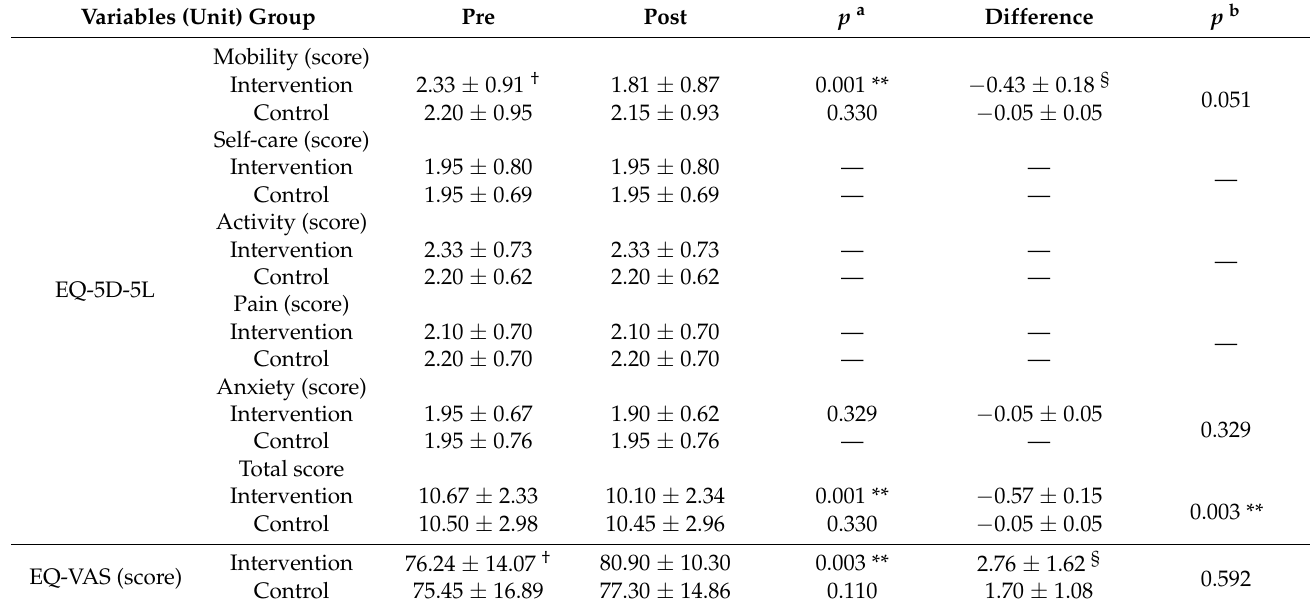
Table 5. Changes in quality of life: EQ-5D-5L and EQ-VAS.